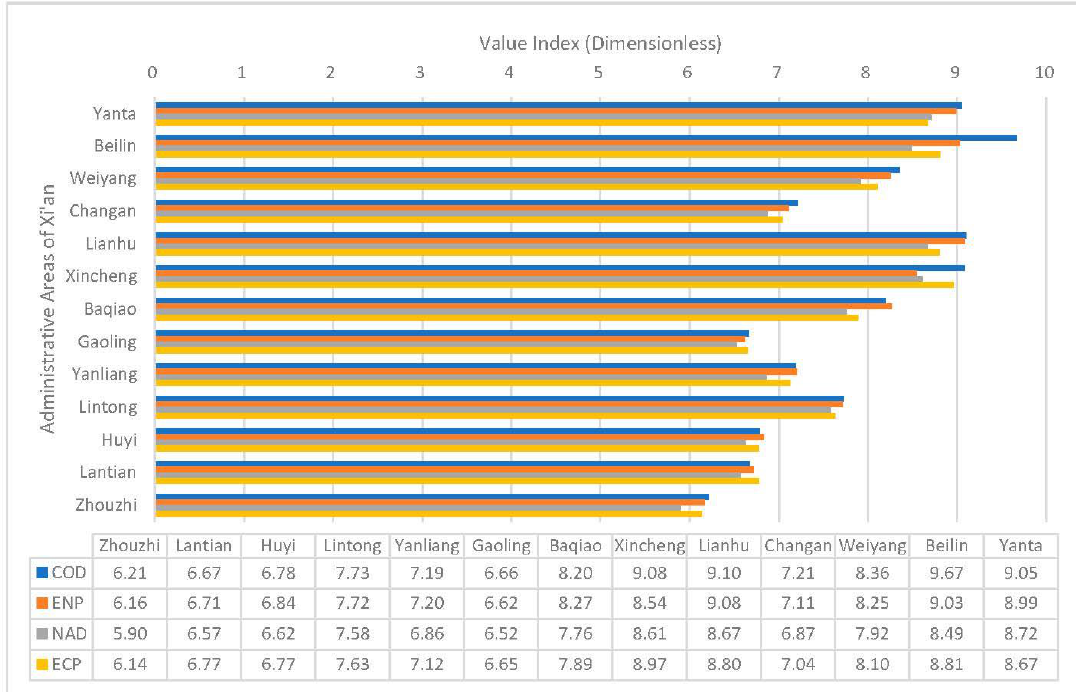
Figure 5. The predicted values of CES in 2030.